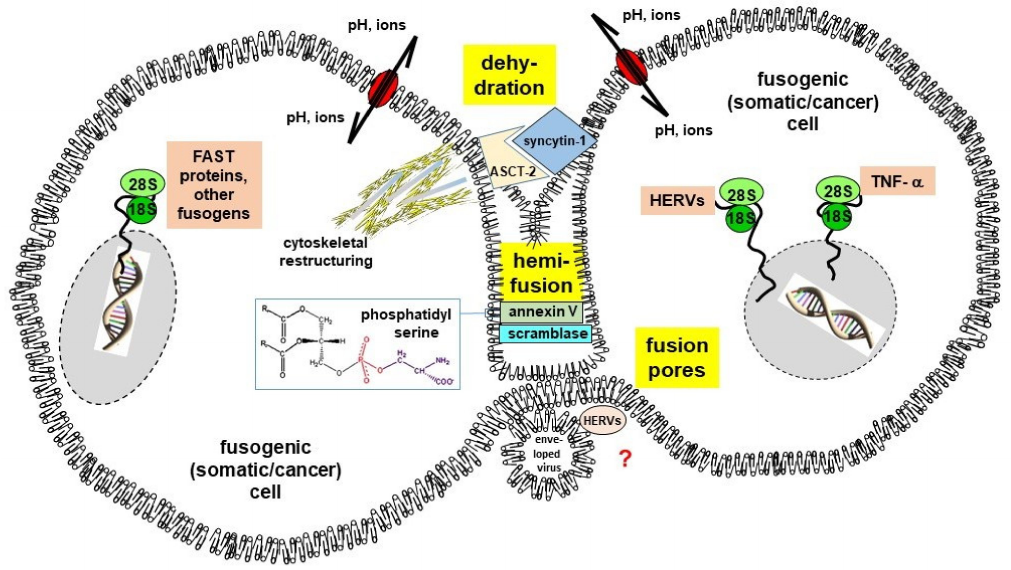
Figure 1. A hypothetic model of potential virus-mediated stepwise (cancer) cell fusion suggests the formation of diaphragm intermediates by the initial merging of the outer lipid layers of adjacent plasma membranes as hemifusion. Expression of fusogenic factors, e.g., syncytin-1 and the corresponding receptor alanine, serine, and cysteine selective transporter-2 (ASCT-2), together with other viral fusogens such as human endogenous retroviruses (HERV) proteins and further cell fusion inducing factors, such as tumor necrosis factor- α (TNF- α ), is required within the cellular fusion partners. Concomitantly, intracellular restructuring of actin cytoskeletal proteins together with an ion gradient and low pH provide a fusion- permissive microenvironment. As a prerequisite, the plasma membranes of the somatic or cancer cells fusion partners in cooperation with the membrane of enveloped viruses have to be localized in close proximity whereby extension of membrane protrusions as lamellipodia can form local fusion pores. Whereas viruses can act as a linker for bridging fusogenic cell membranes the precise molecular role of enveloped viruses to contribute to outer membrane opening, formation of an intermediate hemifusion state, and finally the opening of the inner membrane lipid layers remains enigmatic. Among the various membrane lipids phosphatidylserine (PS) plays an important role in altering the inner lipid membrane structures to enable and finalize the fusion process. Thereby, PS interacts with associated proteins such as annexin V, scramblases, and various cytoskeletal